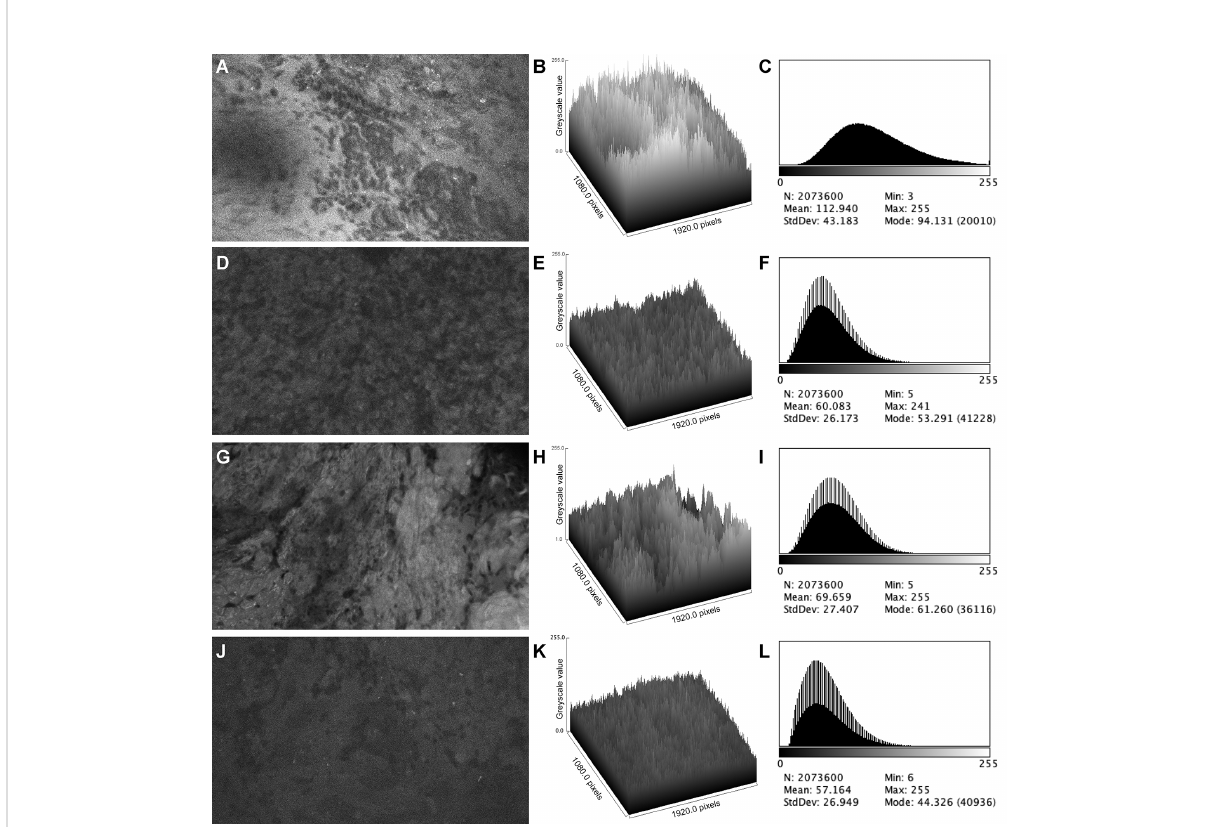
FIGURE 2 Examples of confocal laser endomicroscopy images and data from in vivo and ex vivo studies. In vivo image and data (A – C) show a brighter background and more perceivable cellular structure than the corresponding ex vivo image and data (D – F) . Ex vivo image and data from a patient who had an additional FNa dose (G – I) shows improved overall brightness and contrast compared to the image from the same patient before FNa redosing (J – L) . Mean, brightness; StdDev, brightness; Min and Max, minimum and maximum gray value of pixels in the image; Mode, most frequent occurring gray value in the image. Values are reported in optical density units de fi ned by Fiji software. Used with permission from Barrow Neurological Institute, Phoenix, Arizona